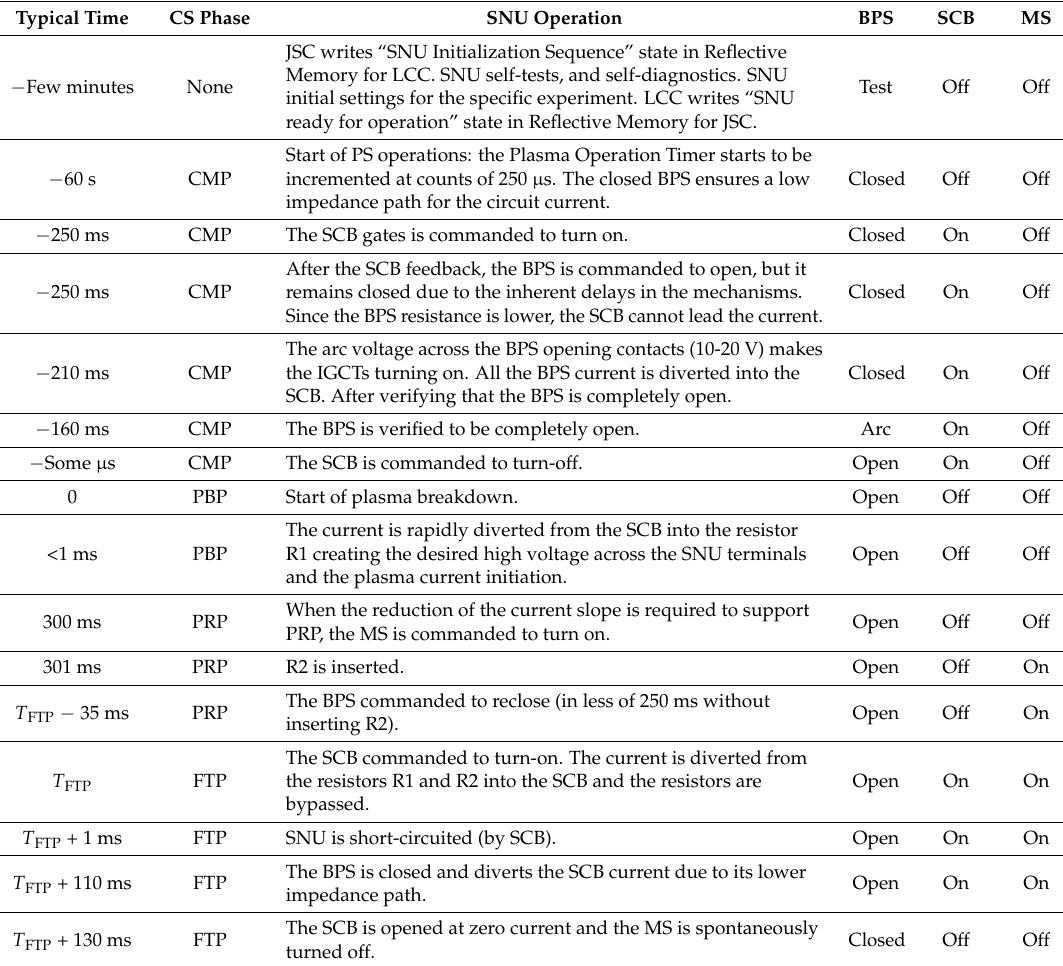
Table 3. Typical sequence of main SNU operations and events with corresponding switch status. Typical